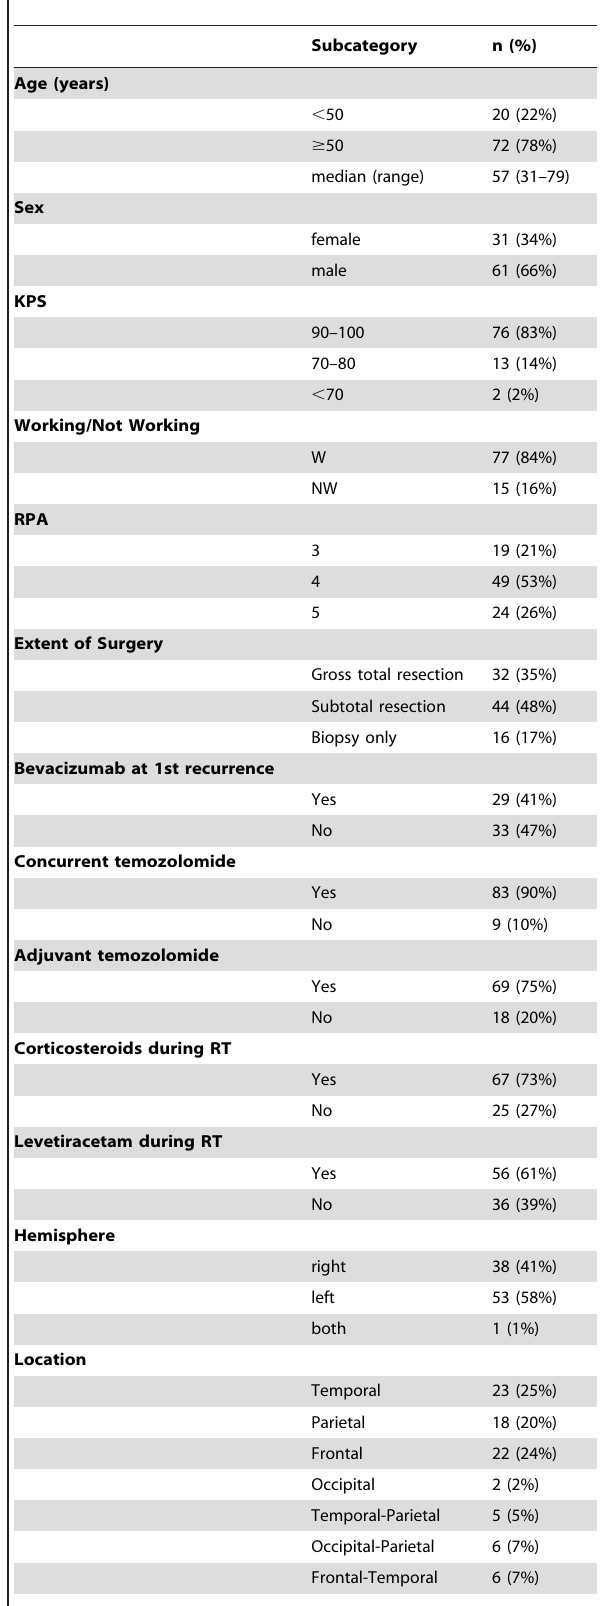
Figure 1. Kaplan-Meier analysis of progression-free survival (PFS) and overall survival (OS) in all patients. The median OS for all patients was 17.9 months (95% CI: 16.3–23.9) and the median PFS for all patients was 7.6 months (95% CI: